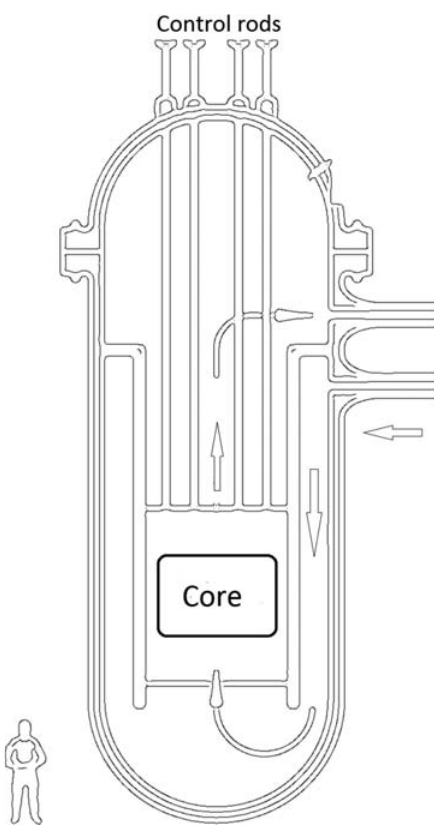
Fig. 6. – Schematic representation of a Supercritical-Water-Cooled